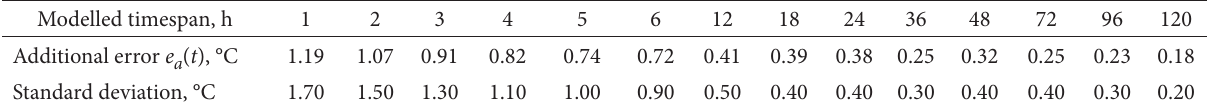
Modelled timespan, h